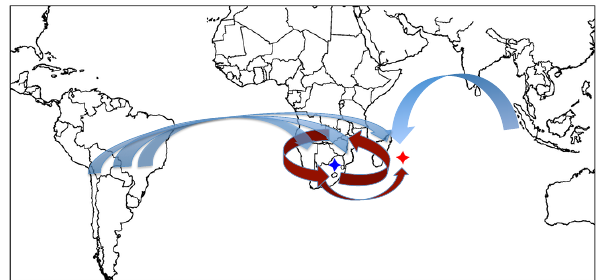
Figure 1. Location of Irene soundings and Johannesburg MOZAIC landing/takeoff profiles (blue star) and Réunion soundings (red star). Also illustrated are typical recirculation patterns over southern Africa and an outflow route to the Indian Ocean (maroon arrows). Flows toward the southern African region and eastern Indian Ocean from South America and southern Asia are indicated by blue arrows (see Fig.